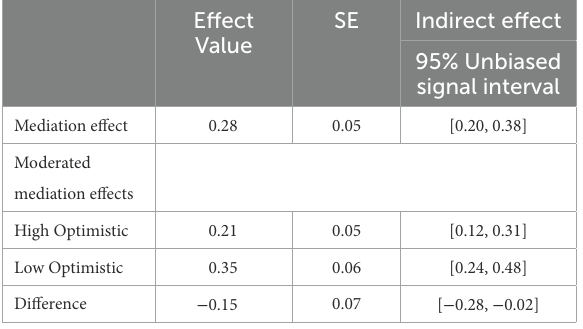
TABLE 4 Summary of mediation effect and moderated mediation effect